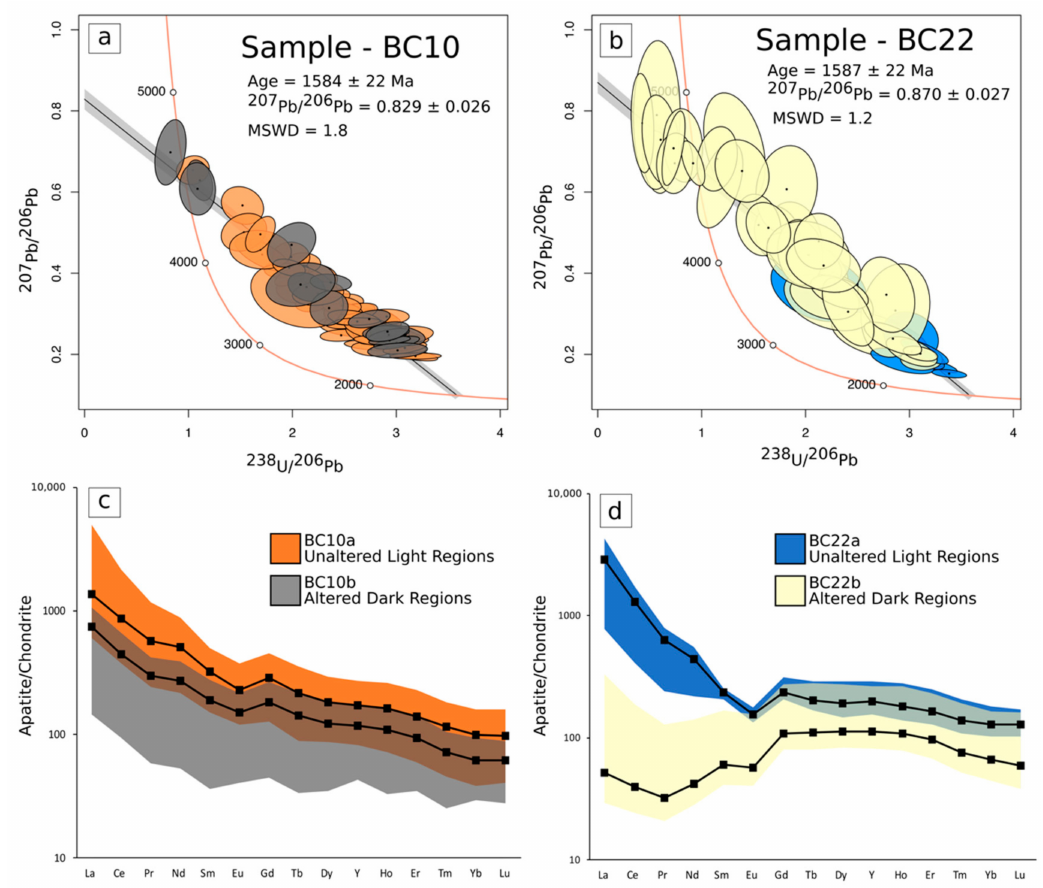
Figure 9. Terra–Wasserburg plot of samples: ( a ) BC10 and; ( b ) BC22. Ovals represent the 2 σ error associated with each analysis. The lower intercept on Terra–Wasserburg plots represent the estimated age of each sample, and the upper intercept represents the common Pb ( 207 Pb/ 206 Pb) estimate. Chondrite-normalized REE profiles for samples ( c ) BC10 and ( d ) BC22. Samples were normalized to Sun and McDonough [40]. BC10b samples are systematically depleted in all REEs compared to the BC10a samples. BC22b samples show a selective depletion in LREEs compared with HREEs, while BC22a samples possess a LREE enriched profile. Dotted lines on the REE plots represent the median value of the samples, while the shaded regions represent the minimum and maximum